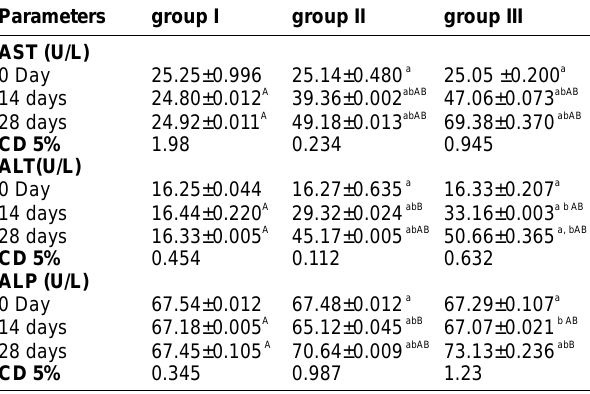
Table-5. Effect on antioxidative parameters following daily oral administration of Jatropha seed oil with our without treatment for 28 days in goats (mean ± S.E., N=3 per